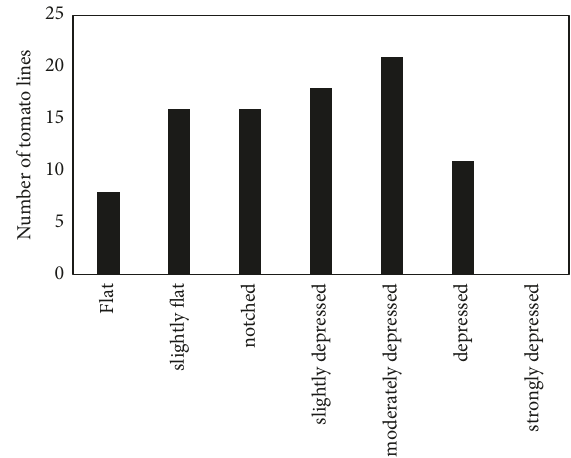
Figure 7: Distribution of ninety-one fresh-market tomato geno- types based on shoulder shape of fruits.